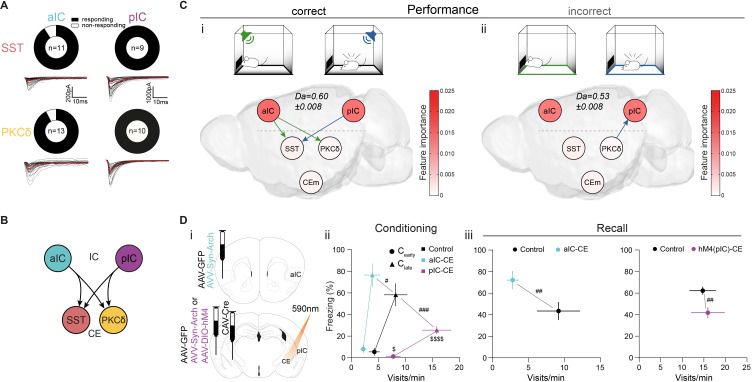
IC-CE information flow facilitates conditioned responding.(A) Fraction of SST+ and PKCδ+ neurons in CEl that responded with EPSCs upon optogenetic stimulation of aIC or pIC input. (B) Scheme for IC inputs to CEl populations. (C) Performance-dependent transfer entropy (TE) between IC and CE nodes for (i) correct (port visits during R-CS and freezing episodes during F-CS) and (ii) incorrect (port visits or freezing outside of corresponding CS) behavioral episodes (±2 s of bin containing behavioral episode onset). RF Decoder accuracy (Da) for decoding behavioral episodes shown above networks. Node color corresponds to RF-associated feature importance, indicating information most relevant for RF classification (see Figure 2—figure supplement 2Ai). (D) (i) Experimental approach to functionally dissect aIC and pIC inputs to CE during a Pavlovian learning task. (ii) Behavioral performance of optogenetic experimental groups in Cearly and Clate stages. Significant MANOVA in Cearly (F2,44=3.60, p=0.0126) and Clate (F2,44=6.43, p=0.0004). (iii) Behavioral performance of the optogenetic (left) and chemogenetic (hM4(pIC)–CE, right) IC–CE treatment cohorts during manipulation-free recall. Significant MANOVA at recall for the aIC-CE manipulation (F1,13=8.18, p=0.005) and pIC-CE manipulation (F1,17=6.81, p=0.0067). Data shown as mean ± SEM. nGFP=9/12 naIC–CE=7, npIC–CE=9/8. Holm post hoc as difference to control is noted as #, between manipulation groups is noted as $. #/$p<0.05, ##p<0.01, ###p<0.001, $$$$p<0.0001. Full statistical report in Appendix 1—table 1.Figure 2—source data 1.Approach and avoidance behavior during conditioning and recall in chemogenetic pIC–CE and aIC-pIC manipulation cohorts.